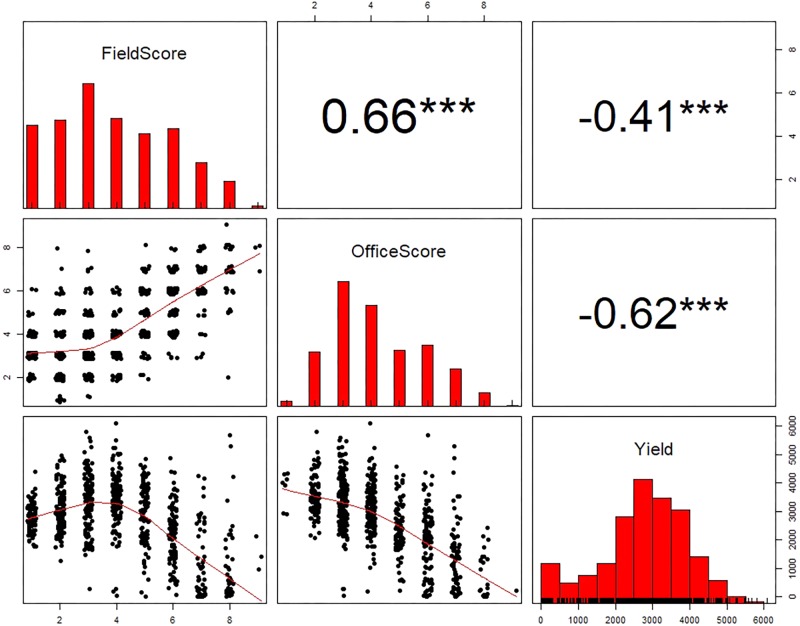
The scatterplots and Pearson’s correlation coefficients among iron deficiency chlorosis field score, office score, and yield for Fields 2, 3, and 4 combined. ∗∗∗ indicates the Pearson’s correlation coefficients are significant at 0.001 level.